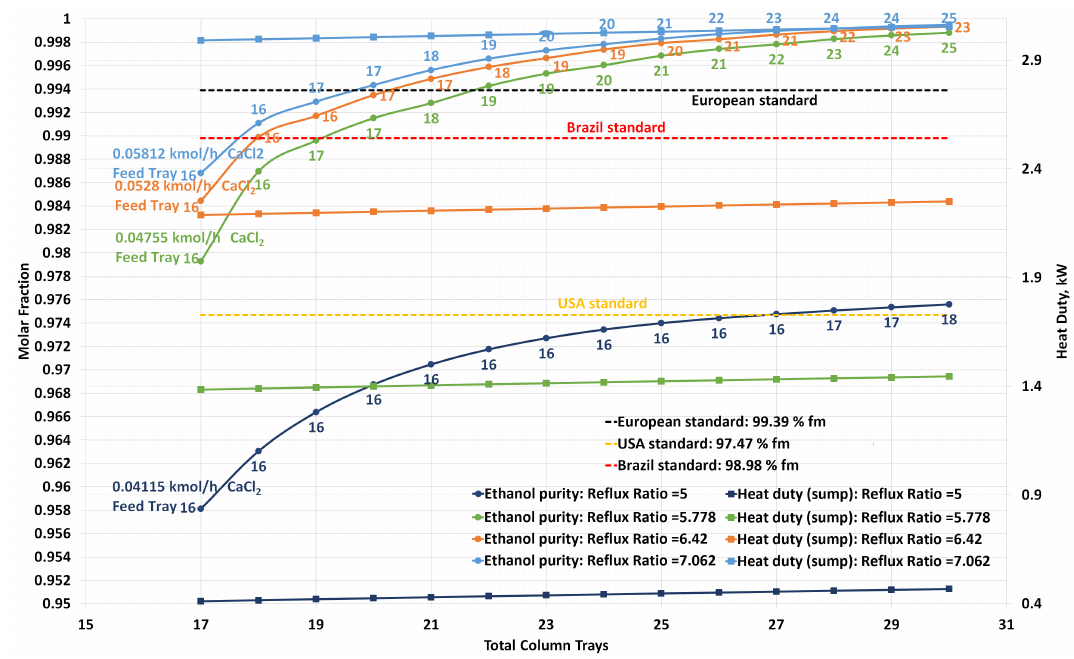
Figure 5. Maximum ethanol purity and the corresponding reboiler heat duty, obtained by considering the indicated feed tray, for different combinations of reflux ratio and total number of